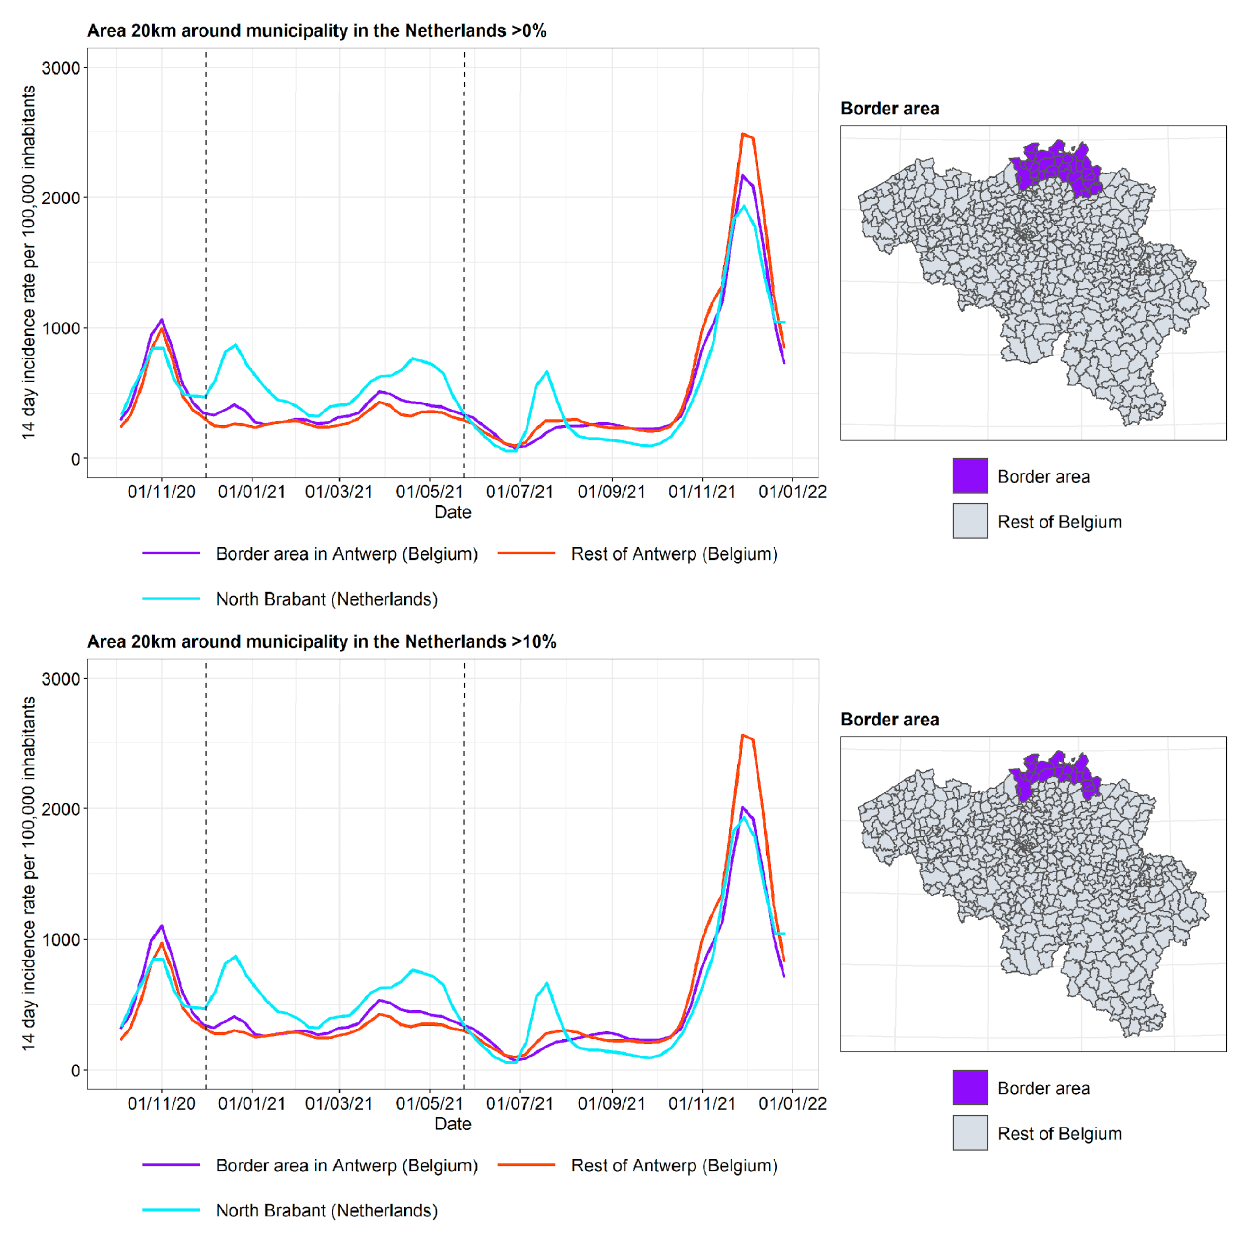
Figure 7. COVID-19 incidence curves for the border area of Antwerp and North Brabant. Selected period for the summary measures in Figure 10 is denoted by vertical dashed lines. The incidence curves are plotted for the border area of the Belgian province, the rest of the Belgian province, and the neighboring Dutch province. Border area membership is determined based on the proportion of the area in a radius of 20 km around the municipality that is located in The Netherlands. The incidence curves are plotted for the border area where the proportion of the area in a radius of 20 km around the municipality that is located in The Netherlands is 0% (wide border area) and 10% (narrow border area), respectively. In this way, the gradient of the impact of the incidence curve on the other side of the border can be